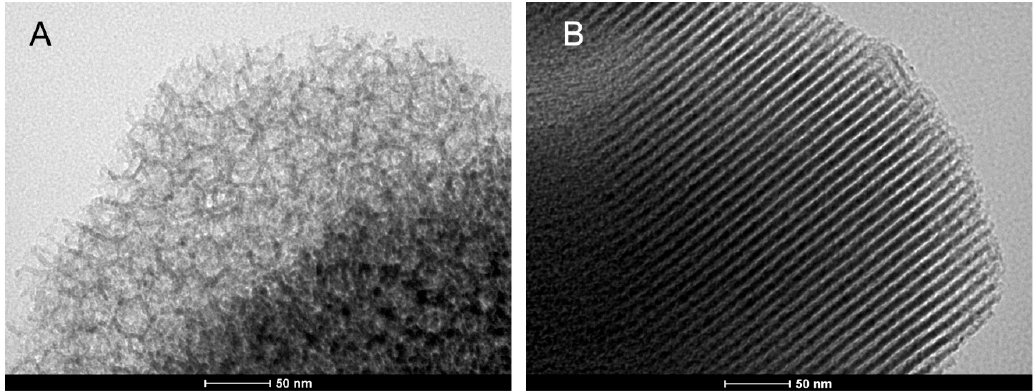
Figure 2. The TEM image of synthesized carriers ( A ). MCF ( B ). SBA-15 before functionalization. Table 1. Immobilization of AcmB on silica carriers: Mesoporous cellular foam (MCF) and Santa Barbara Amorphous (SBA). The AcmB activity was measured in the presence of 1.5 mM